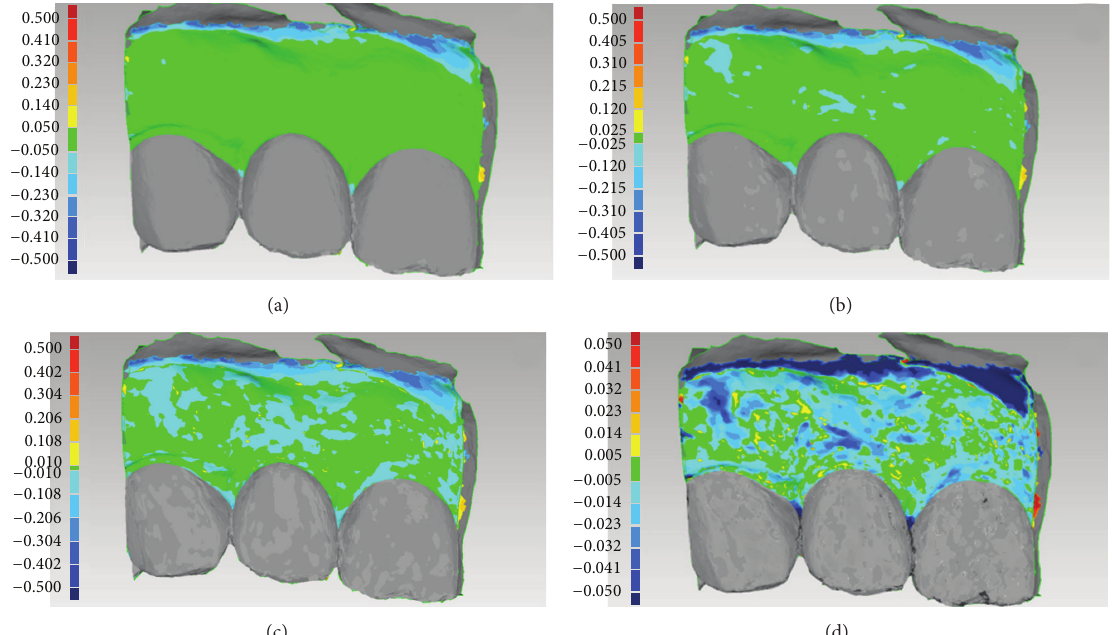
Figure 2: Immediate implant placement in postextraction socket ( test group) of an adult female patient (34 years old): (a) overlapping of digital images (S2 over S1): colorimetric map, first setting (50 𝜇 m). Since the variations in soft tissue volume over 2 years did not exceed 50 𝜇 m, the only color visualized was green; (b) overlapping of digital images (S2 over S1): colorimetric map, second setting (25 𝜇 m). Only in a few restricted areas was a variation/reduction in soft tissue volume > 25 𝜇 m registered: therefore, the predominant color was still green; (c) overlapping of digital images (S2 over S1): colorimetric map, third setting (10 𝜇 m). Overall, the soft tissues were stable and did not show contractions > 10 𝜇 m, but the soft tissues overlying the vestibular (bundle) bone showed some kind of variation/reduction over time, as they were depicted in light blue; (d) overlapping of digital images (S2 over S1): colorimetric map, fourth setting (5 𝜇 m). The area of the vestibular mucosa overlying the vestibular (bundle) bone was clearly the most affected by tissue contraction over time, although the mean ( ± SD) soft tissue reduction in the whole inspected area amounted to 0.024 mm ( ± 0.048)